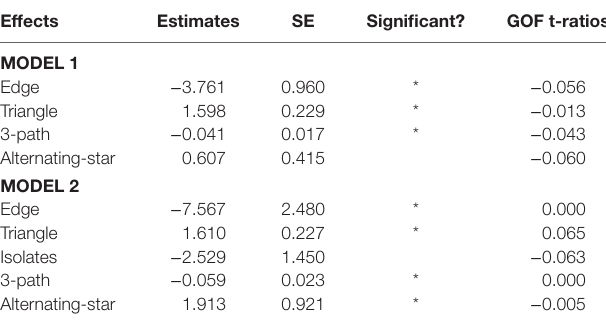
TaBle 6 | Two estimated exponential random graph modeling models with a good fit to the observed visibility network shown in Figure 11